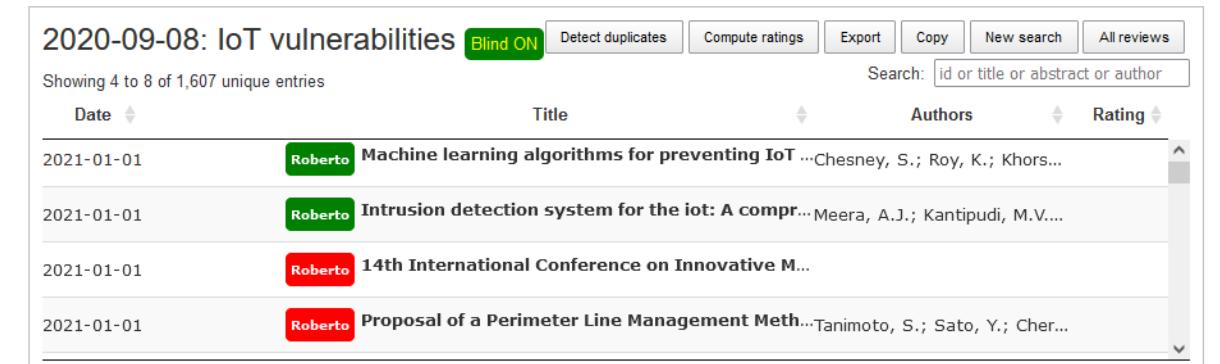
Figure 2. Screenshot of the tool Rayyan used during screening process to select the primary sources for the full text review process.